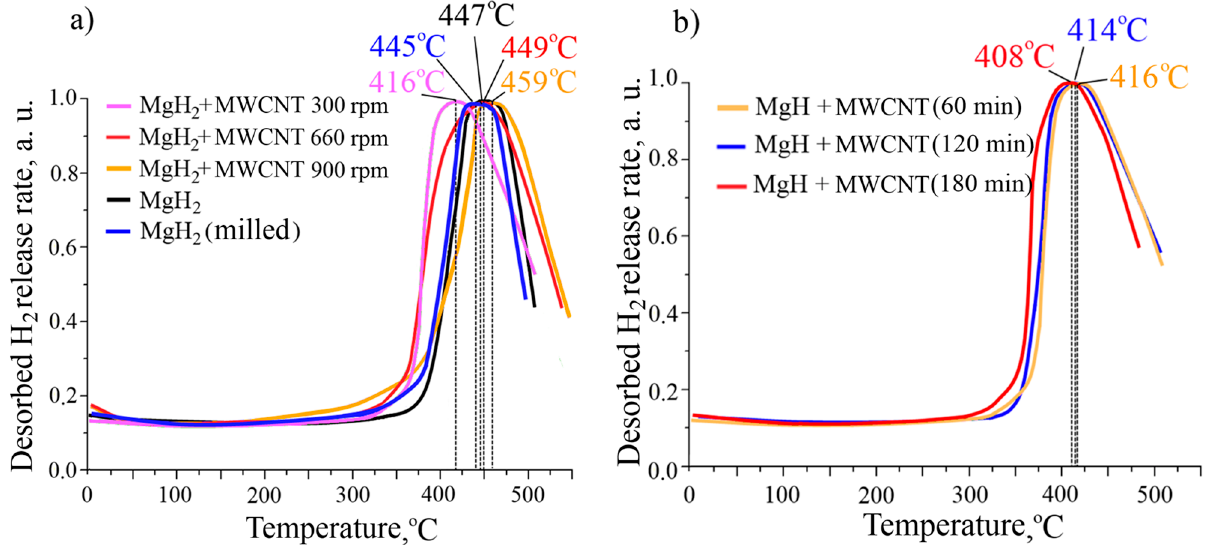
Figure 9. Hydrogen thermal desorption spectroscopy curves for magnesium hydride and MgH 2 –5 wt.% SWCNT composites obtained as a result of milling for 60 min at a different speeds ( a ) and at a speed of 300 rpm and different duration of milling ( b ).